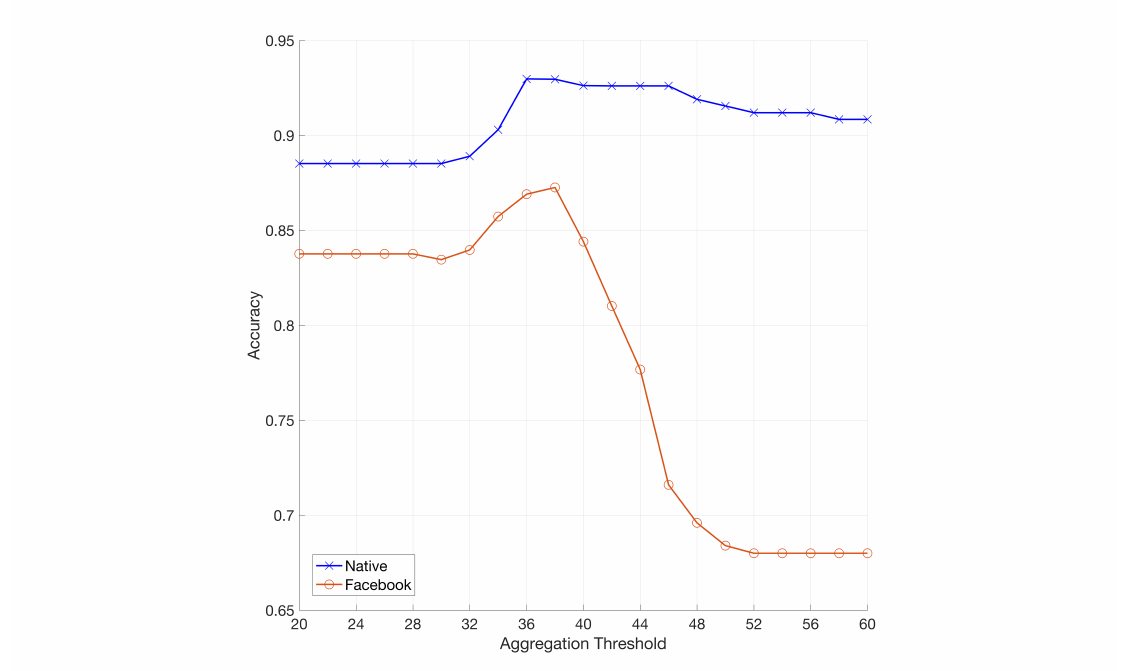
Figure 5. (Best viewed in color) Mean accuracy of source identification on digitally stabilized videos by varying the aggregation threshold τ . Native and Facebook (HQ) contents are referred in blue and orange